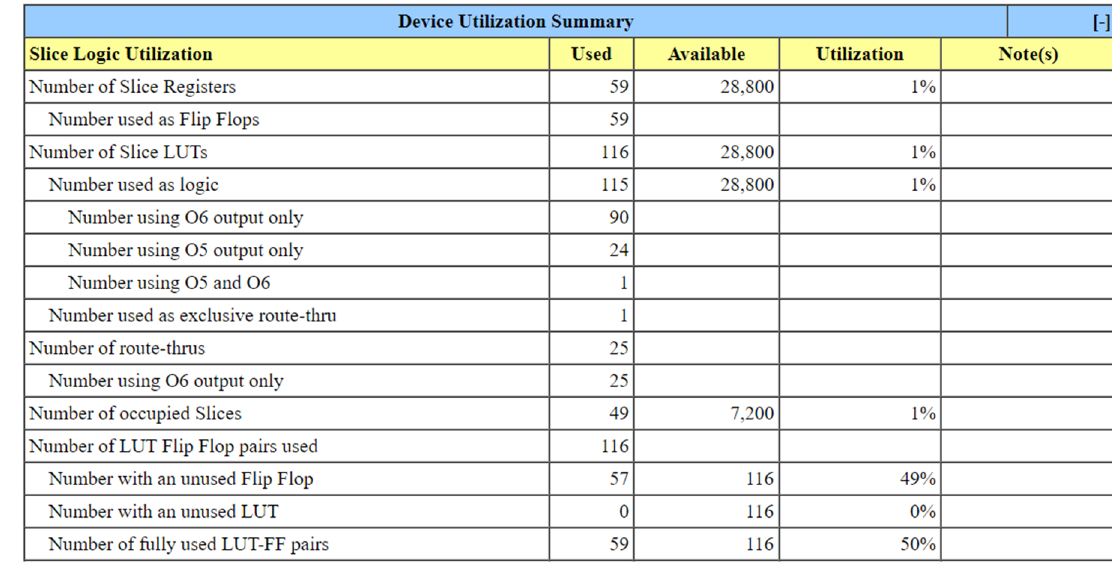
Figure 6. FPGA utilization summary.